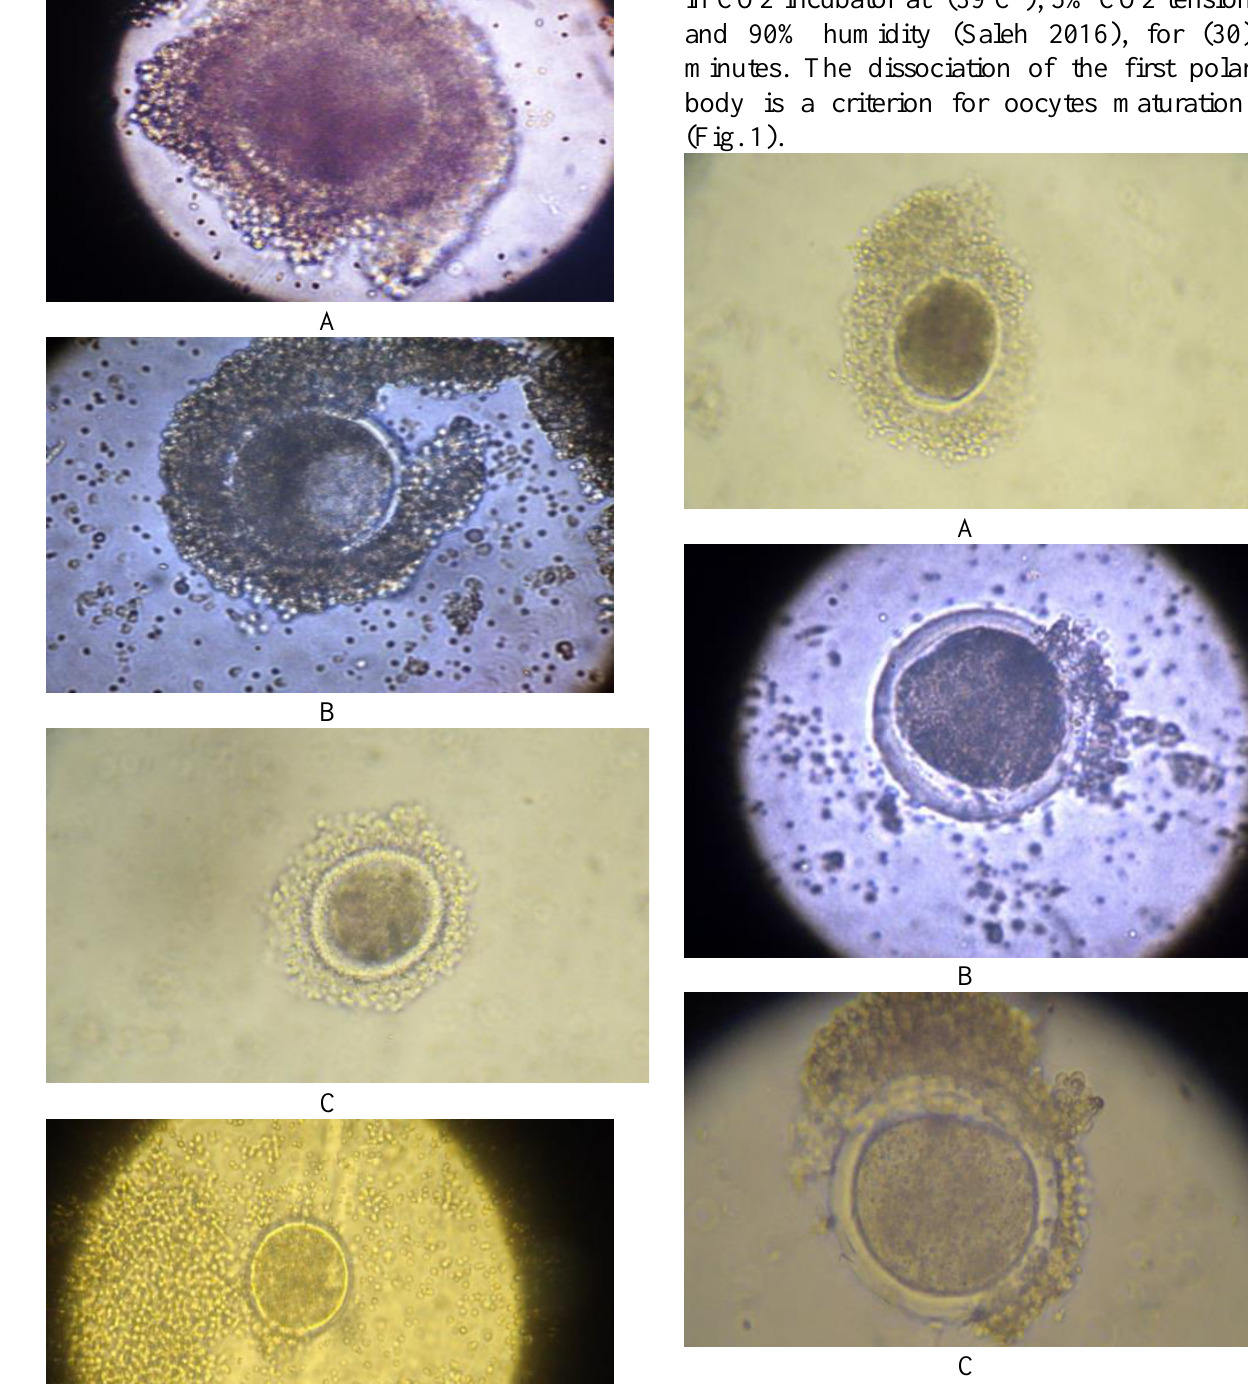
Figure, 2: Three mature oocytes where the red arrows denoted the dissociation of the first polar